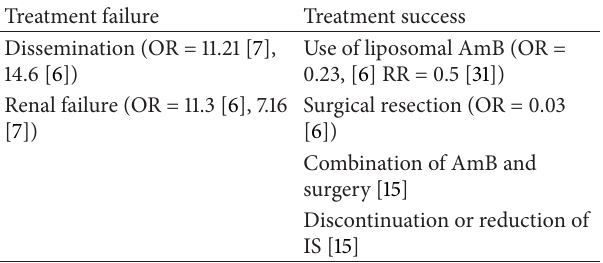
Table 2: Factors affecting outcome of Mucormycosis infection. Treatment failure Treatment success Dissemination (OR = 11.21